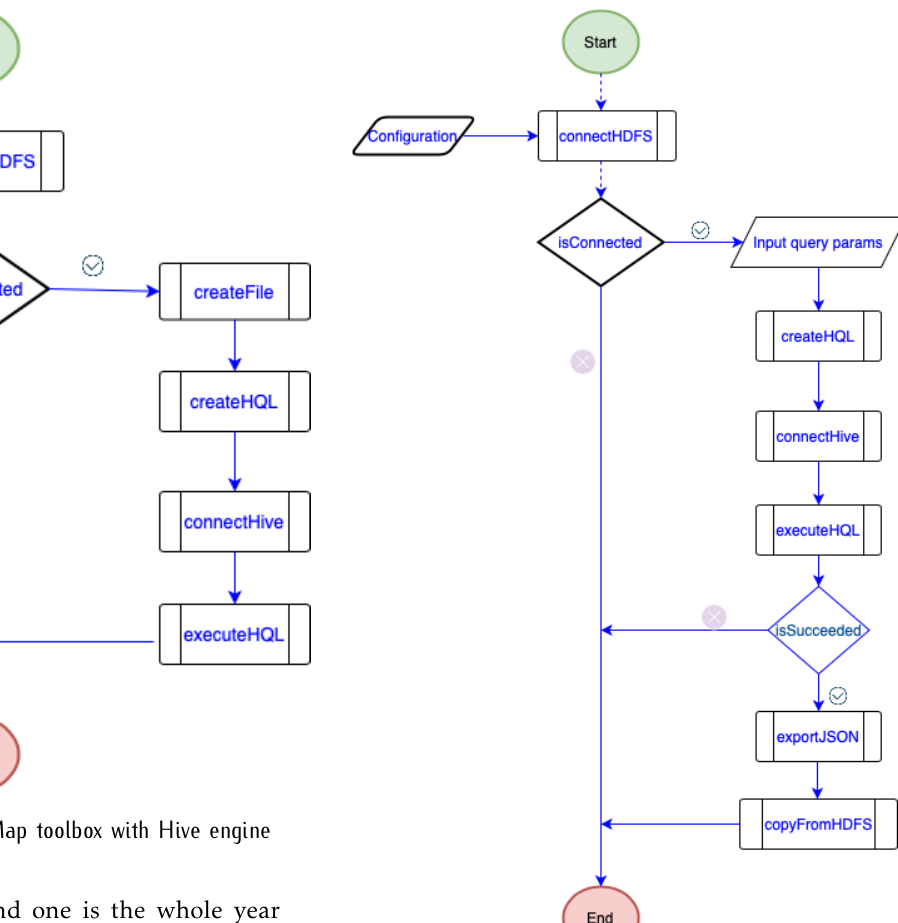
Figure 6. Implementation flow of Query